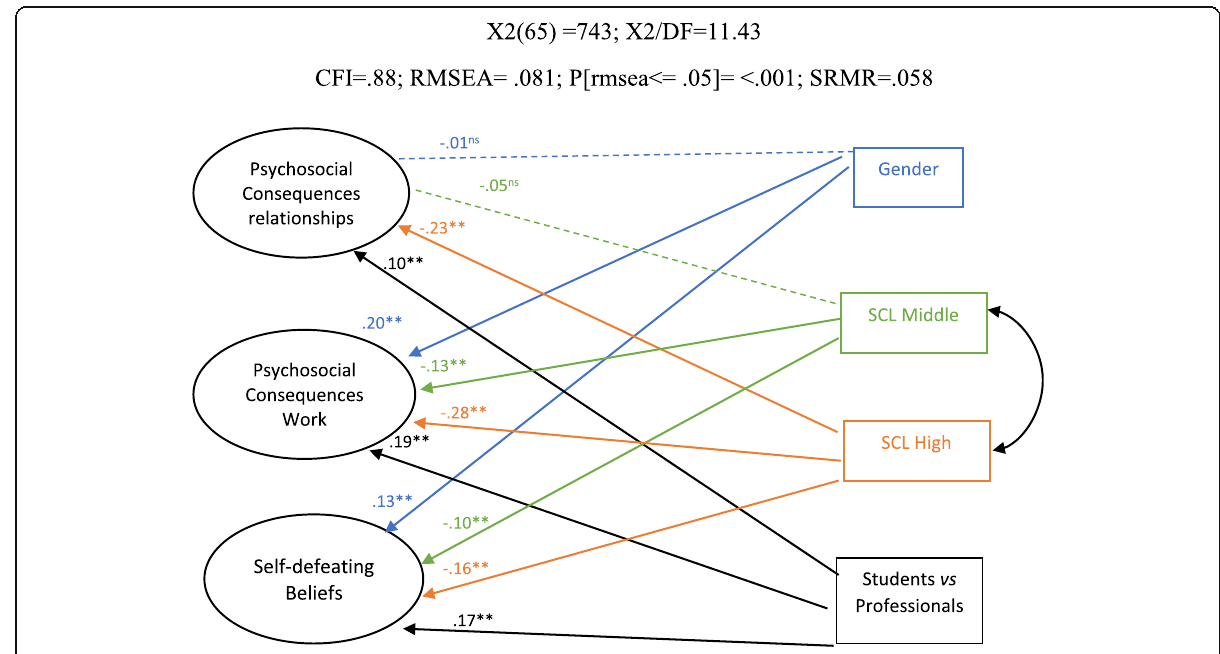
Fig. 2 Mimic — the effect of gender, sociocultural level (SCL) and group of origin on the